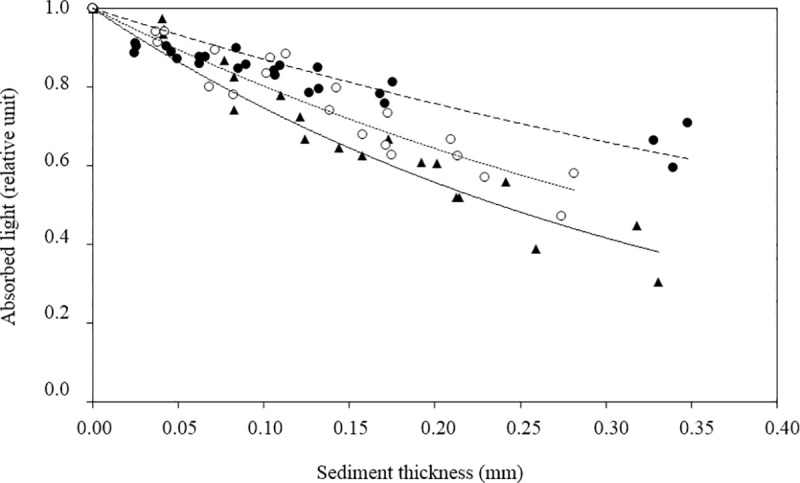
Absorbance of light as a function of sediment thickness and percentage of fine grained content enabled estimation of the light attenuation coefficient (k*d(sed); mm-1).Black triangles: sampling sites O (8.61%), white circles: H (51.50%); black circles: M (69.70%). k*d(sed) is defined as the coefficient a of the equation y = e ax. Here the coefficients obtained for O, H, and M were 2.35, 3.68, and 4.76 mm-1 respectively.